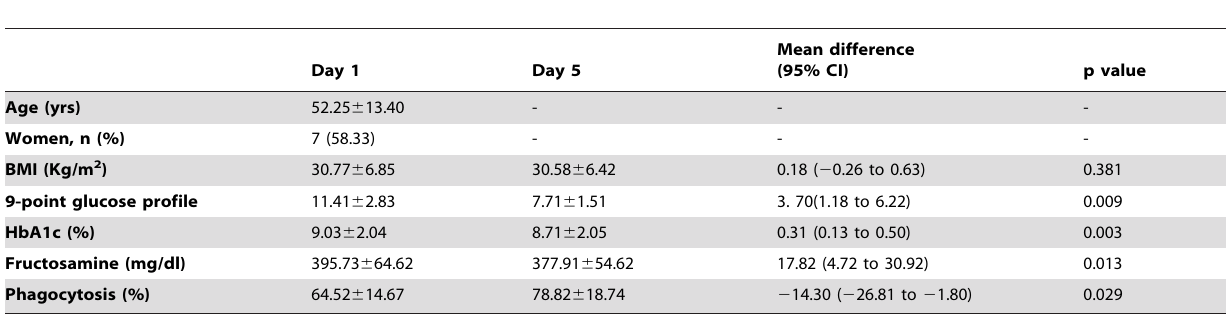
Table 2. Main clinical characteristics and metabolic data at baseline (day 1) and discharge (day 5) of type 2 diabetic patients (n=12) included in the interventional